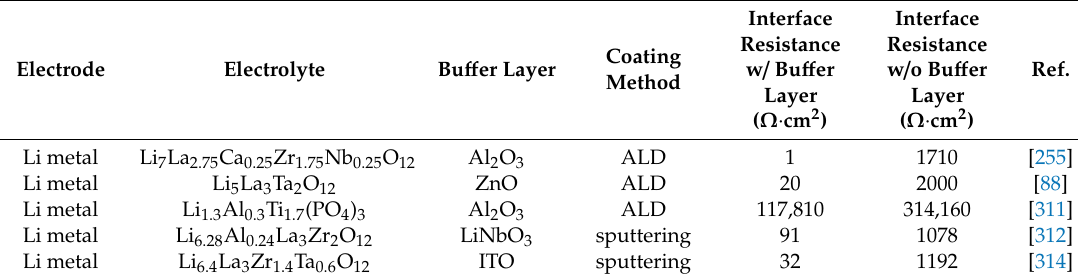
Table 5. Comparison of the interface resistance with (w / ) and without (w / o) bu ff er layer on solid-state electrolyte /